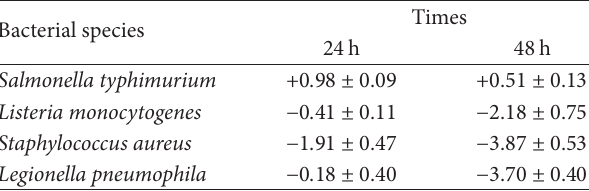
Table 1: Variation in intracellular bacterial concentrations at differ- ent times after infection of human macrophages. Data are expressed as increment (+) or reduction ( − ) of log CFU ± SEM. Bacterial